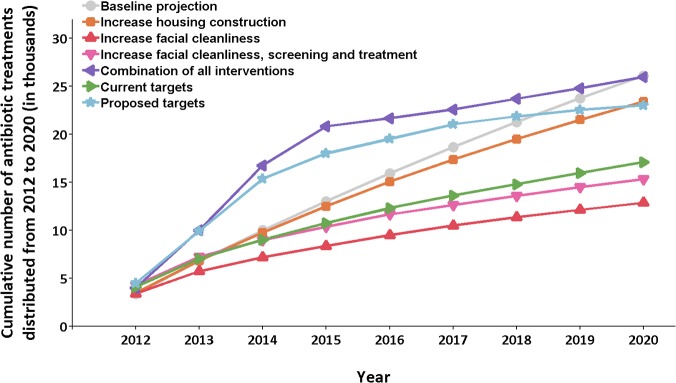
The cumulative number of antibiotic treatments distributed in the predominantly hyperendemic region under a selection of the future intervention scenarios between 2012 and 2020.The reduced number of antibiotics required under the ‘increase facial cleanliness’, ‘increase facial cleanliness, screening and treatment’, and ‘current targets’ future scenarios reflects the lower incidence rates observed when the young population has a higher clean face prevalence. This lower incidence results in a lower disease prevalence and therefore fewer communities require large scale antibiotic programs to control the disease. The ‘proposed targets’ and ‘combination of all interventions’ scenarios illustrate the sharp initial increase in antibiotic distribution required to implement policies in which repeated MDA is administered to hyperendemic communities. However, the antibiotic distribution effort required under these scenarios is drastically reduced following an early peak, demonstrating the effectiveness of such programs in drastically reducing disease prevalence.